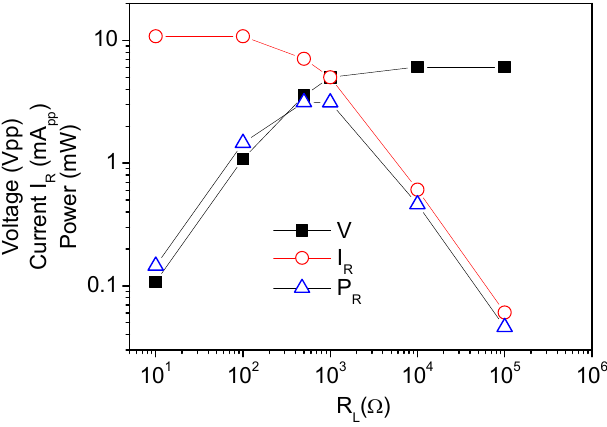
Figure 7. Output performance of the energy harvester as a function of load resistance.